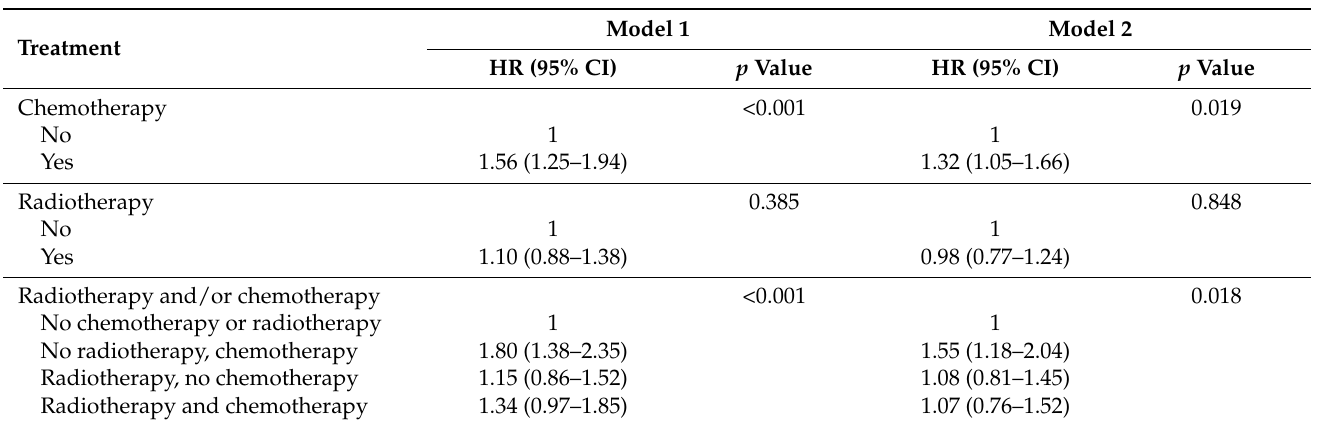
Table 3. Hazard ratios and 95% confidence intervals for the association of cancer treatment with CVD mortality in men diagnosed with breast cancer, SEER registry (2000–2019).